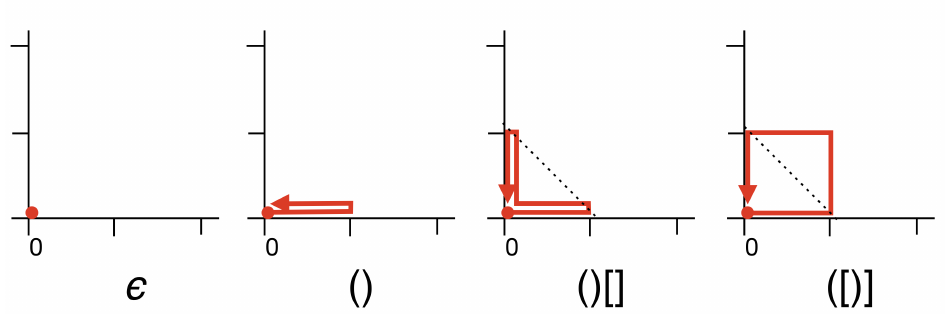
Figure 7. Derivation of the SDL 2 word ‘([)]’, viewed as an evolving lattice walk. An insertion move shows as an out-and-back spike directed away from the origin. Neighboring parentheses of unlike style show up as a 90-degree corner. Making a shuffle move folds or unfolds the corner,